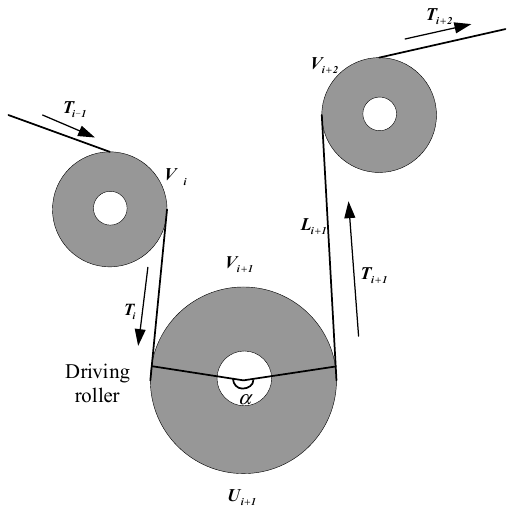
Figure 4. Analysis of electromagnetic brake.